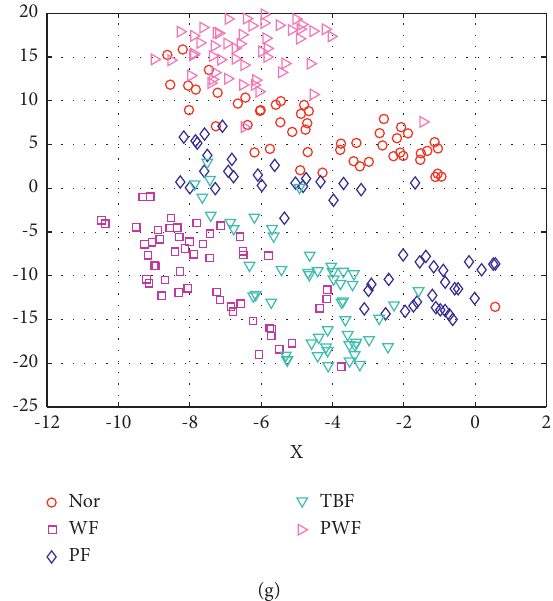
Figure 21: The two-dimensional feature visualization map obtained by